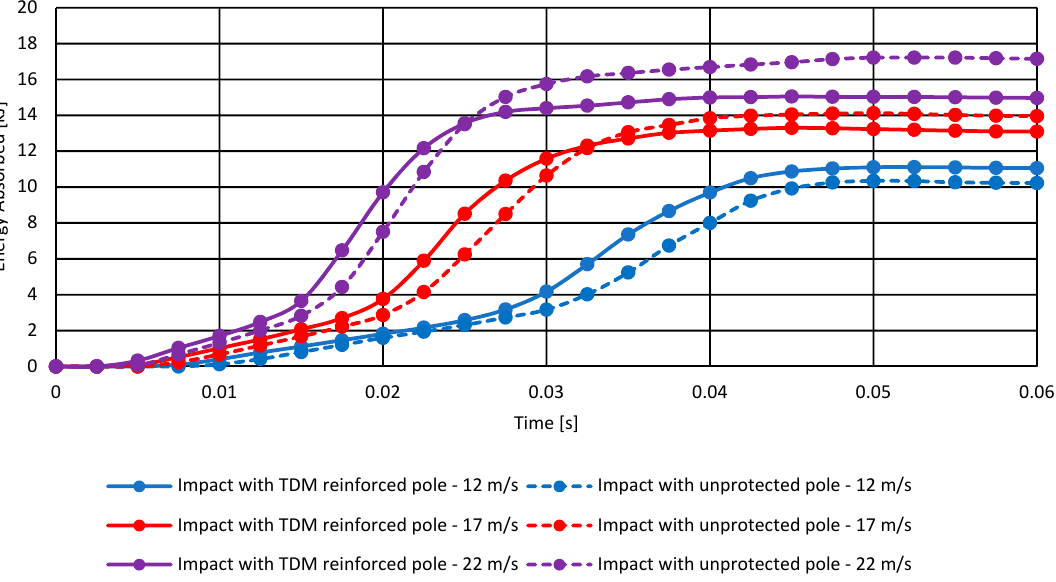
Figure 12. Impact energies absorbed by the vehicle on a street pole (using the frontal collision method) with a TDM reinforcement of 35 mm using three different speeds at 12 ms − 1 , 17 ms − 1 and 22 ms − 1 .